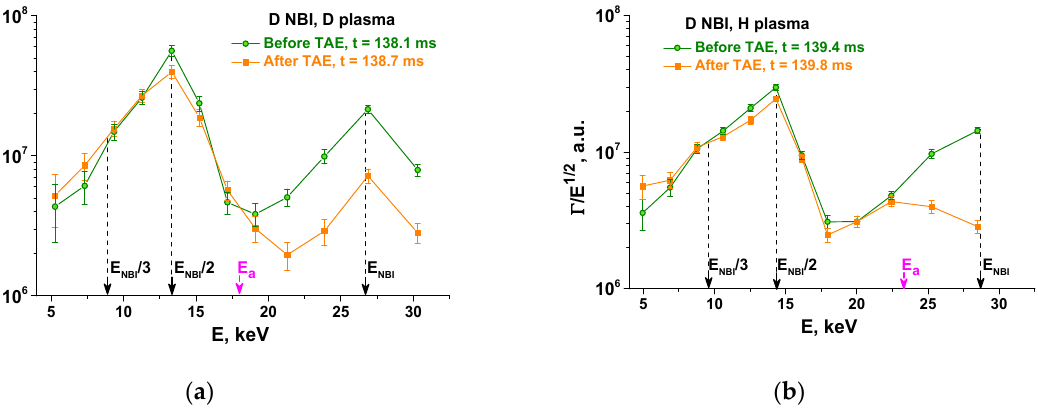
Figure 16. CX spectra measured before (green) and after (orange) the TAE burst: ( a ) D injection into D plasma, discharge #31996; ( b ) D injection into H plasma, discharge #31784. E a —energy corre- sponding to the Alfvén velocity. Figure ( a ) is taken from [45] and reproduced with permission from IOP Publishing.